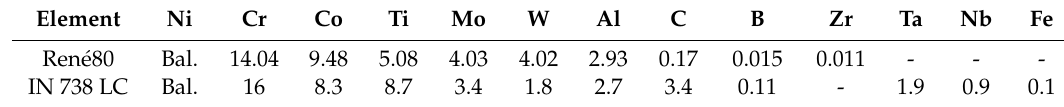
Table 1. Chemical composition of Ren é 80 and IN 738 LC (taken from Hermann, W. (2014) [26]) in wt.%.